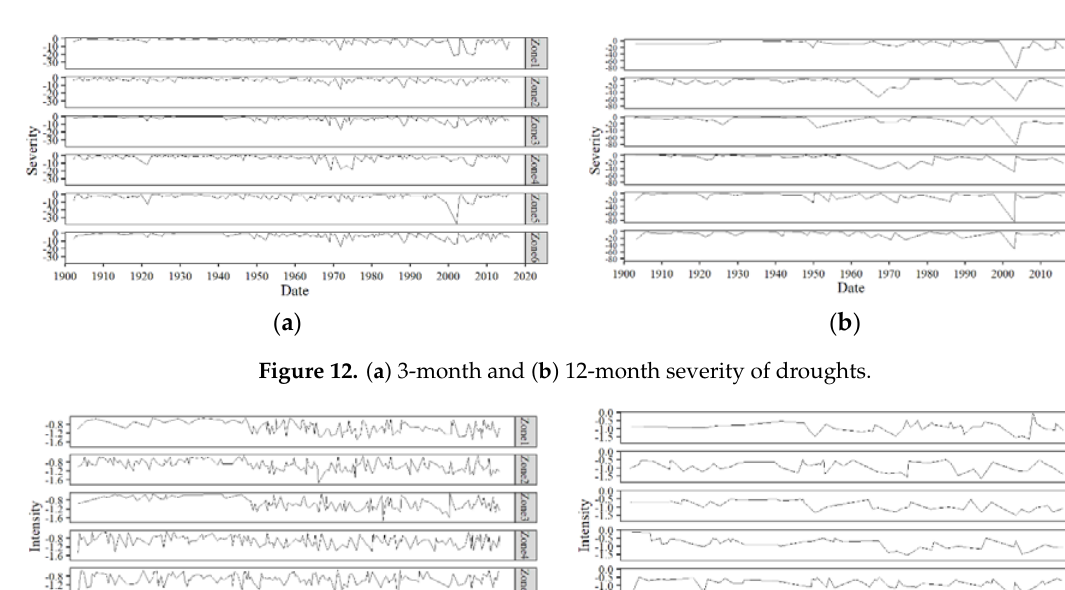
Figure 11. ( a ) 3 ‐ month and ( b ) 12 ‐ month durations of droughts.